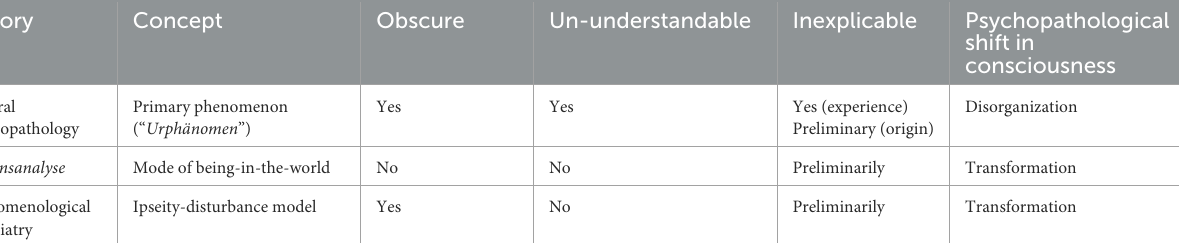
TABLE 1 A scheme for structuring the debate on schizophrenic